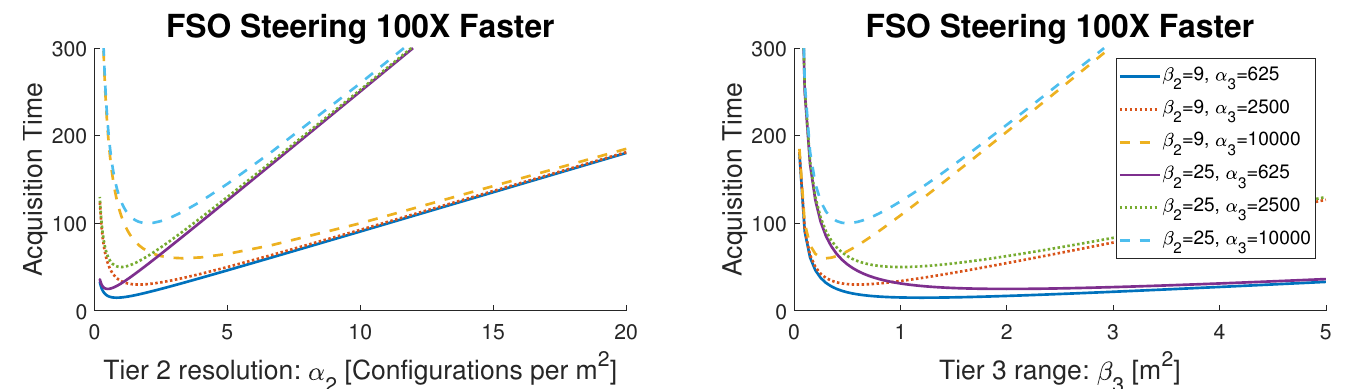
Figure 6. Maximum search time for MTH protocol as a function of Tier 2 resolution (i.e., α 2 ) and Tier 3 range (i.e., β 3 ) when t 2 / t 3 = 100.